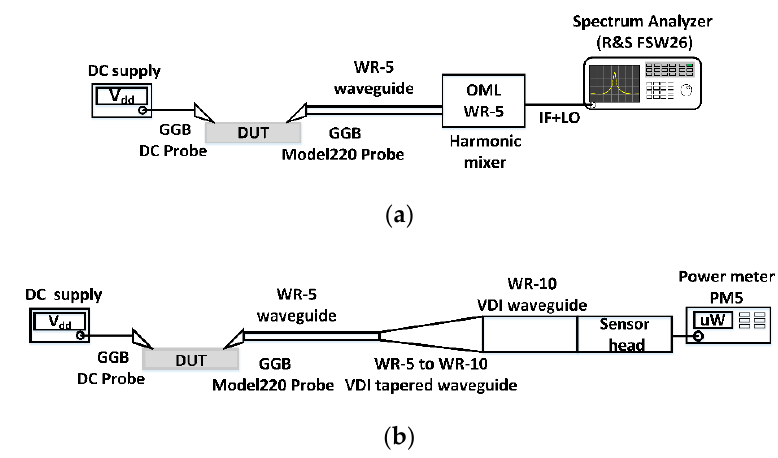
Figure 7. ( a ) Output spectrum measurement setup; ( b ) output power measurement setup.